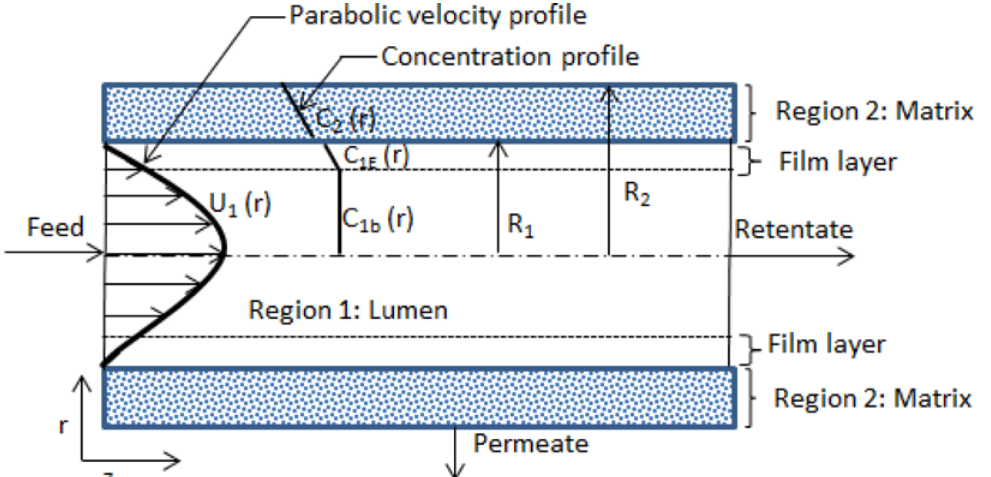
Fig 1. A cross-section of the membrane bioreactor illustrating the different regions of the MBR (i.e. lumen, film layer, and matrix). The velocity distribution and concentration distribution are also shown.